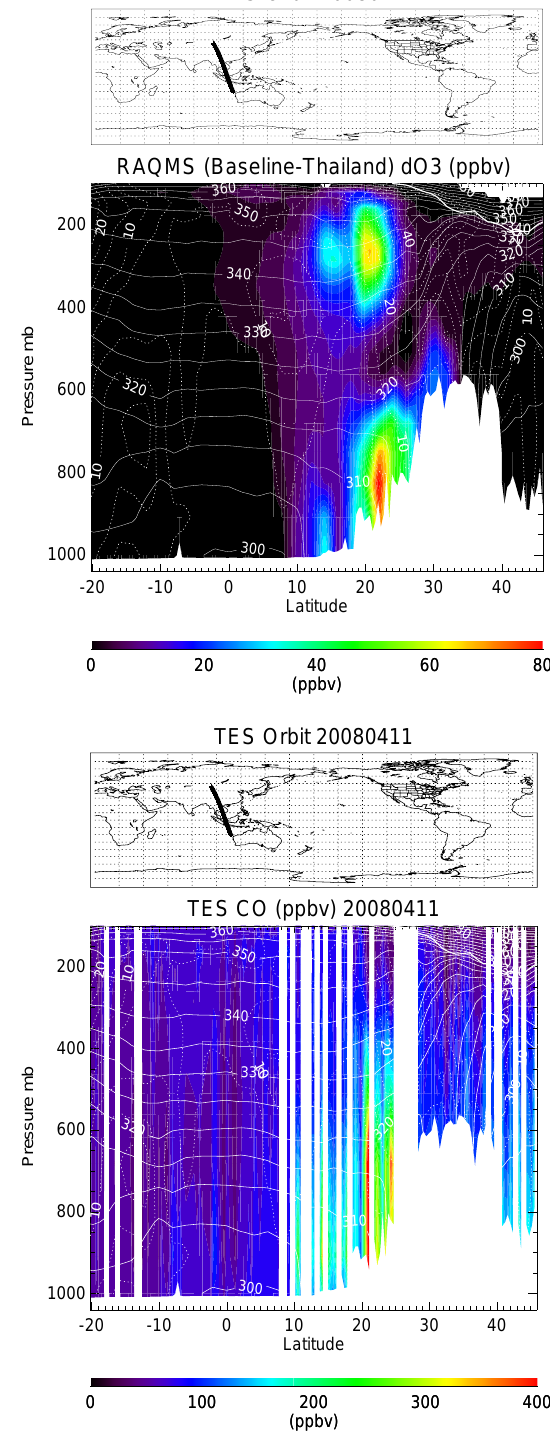
Fig. 12. (Top panel) Estimated ozone due Thailand fires from RAQMS sensitivity runs (bottom panel) estimated CO due to Thai- land fires. Right panel shows the orbit track. These figures should be compared to the observed ozone from TES in Fig.